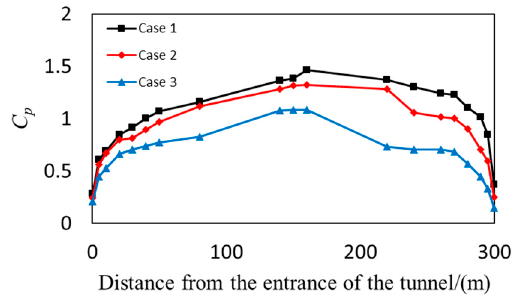
Figure 15. Peak to peak values of (cid:1829) (cid:3043) on the tunnel wall.